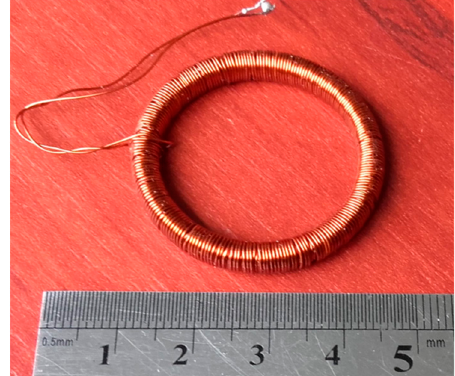
Figure 1. Typical sample used in the investigation, a ring-shaped core with a small cross-section, with 400 sensing windings, ensuring high measurement signal. Magnetization was provided with a straight magnetizing rod, which ensured a homogenous magnetizing field in the sample.